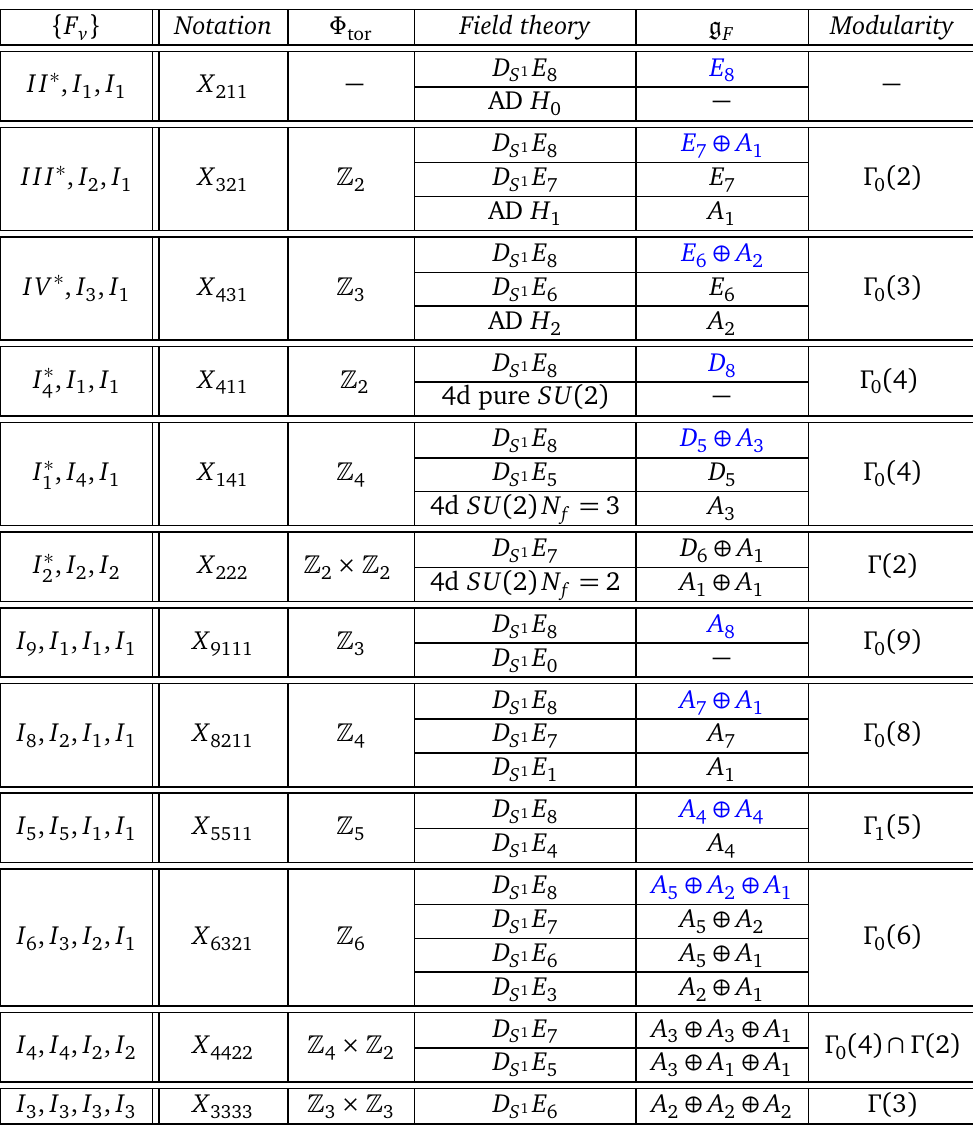
Table 7: Extremal rational elliptic surfaces with I